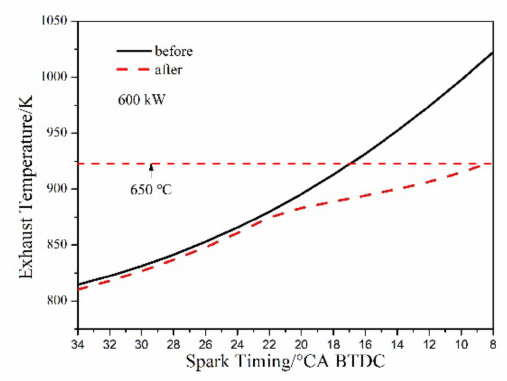
Figure 12. Comparison of exhaust temperature before and after